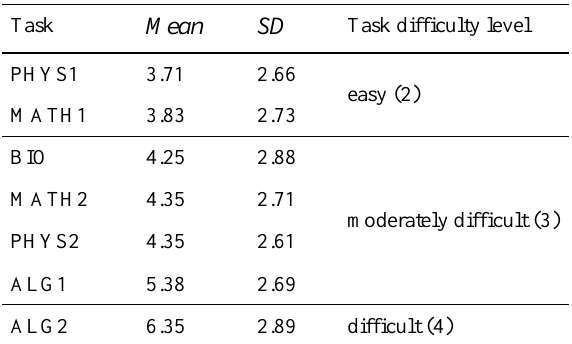
An evaluation of the task difficulty level by the students (N=48).